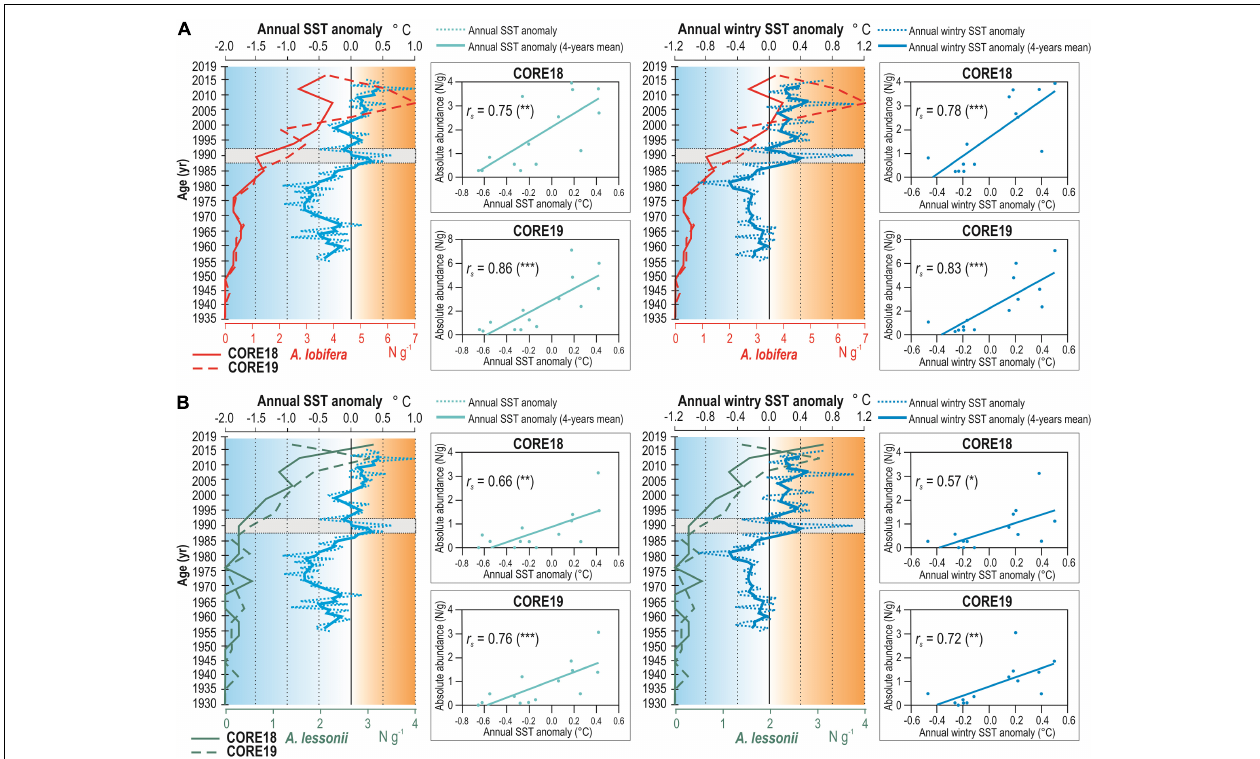
FIGURE 7 | Curves reporting from left to right: absolute abundance of A. lobifera (A) and A. lessonii (B) plotted against the annual SST anomaly and wintry SST anomaly evaluated over the period 1955–2015. Beside: scatter-plots with Spearman’s coefficients ( r s ) relative to the absolute abundances of A. lobifera and A. lessonii recorded in CORE18 and CORE19 compared to the annual and wintry SST anomalies ( p -values of correlation indicated in brackets as follows: * p < 0.05; ** p < 0.01l; *** p < 0.001). The beginning of the exponential growth of both populations starts around the 1990s, when the warmer phases (in orange) abruptly increase in intensity and